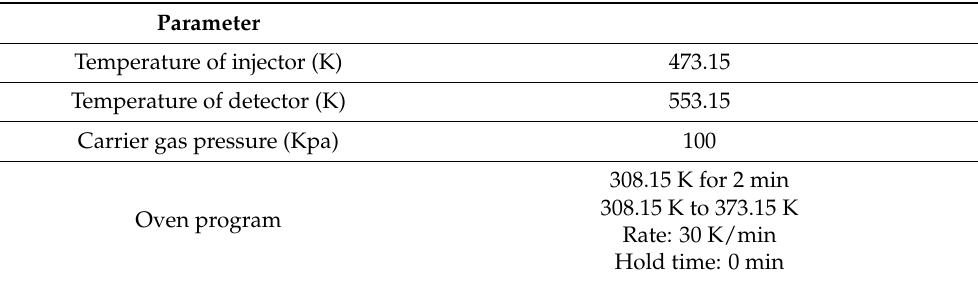
Table 5. GC conditions for the toluene/1-hexene